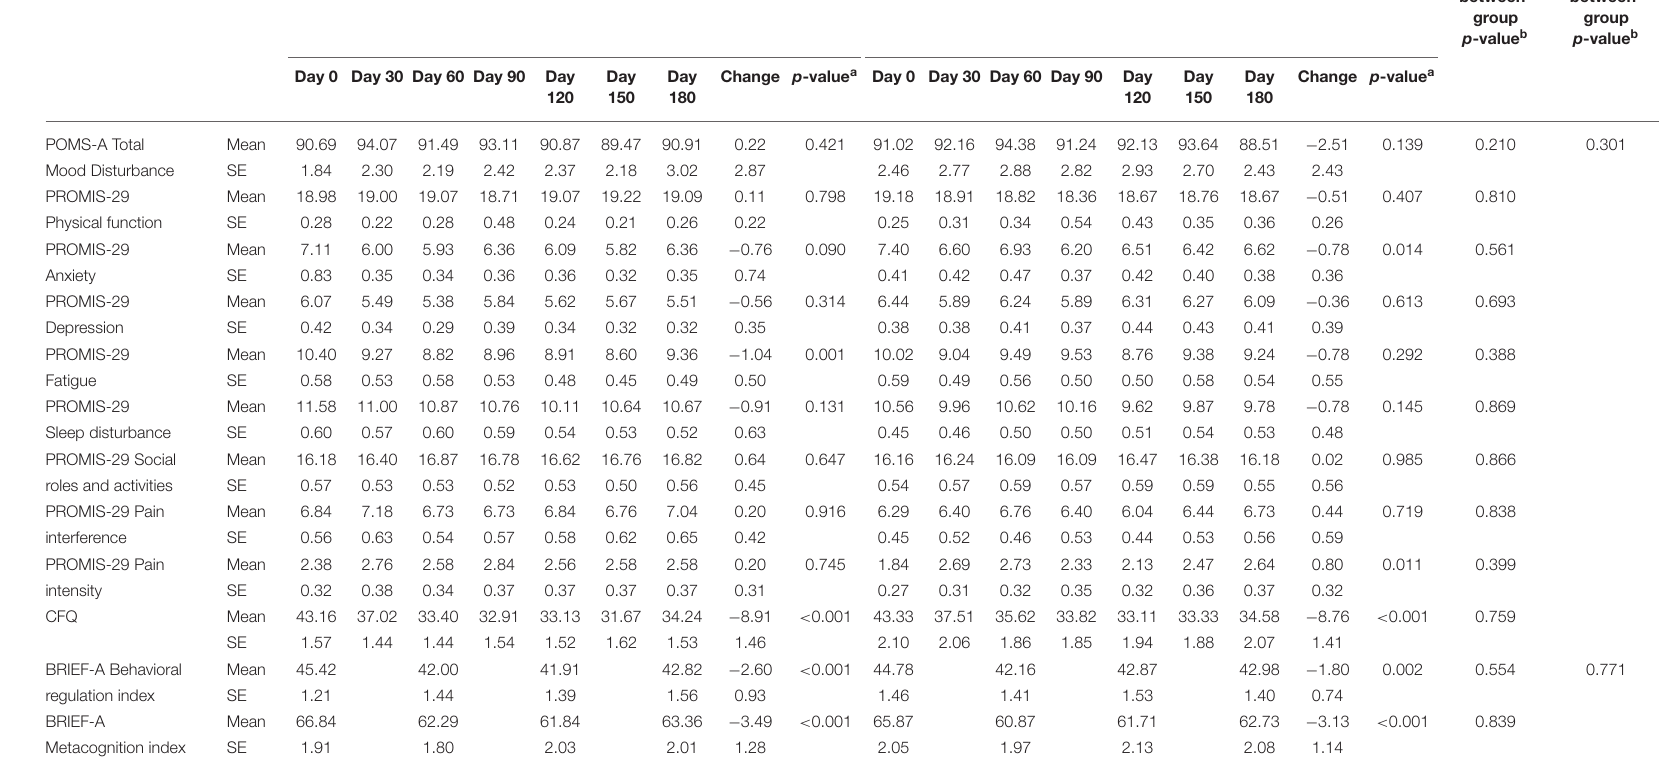
Placebo ( n = 45) Lutein/zeaxanthin ( n = 45) Univariate